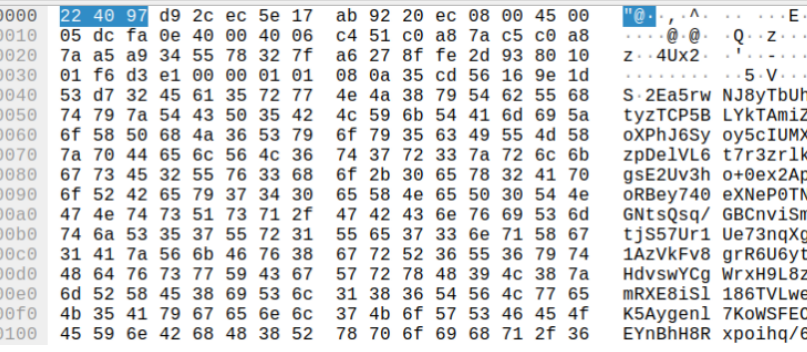
Figure 11. Encrypted data package capture.